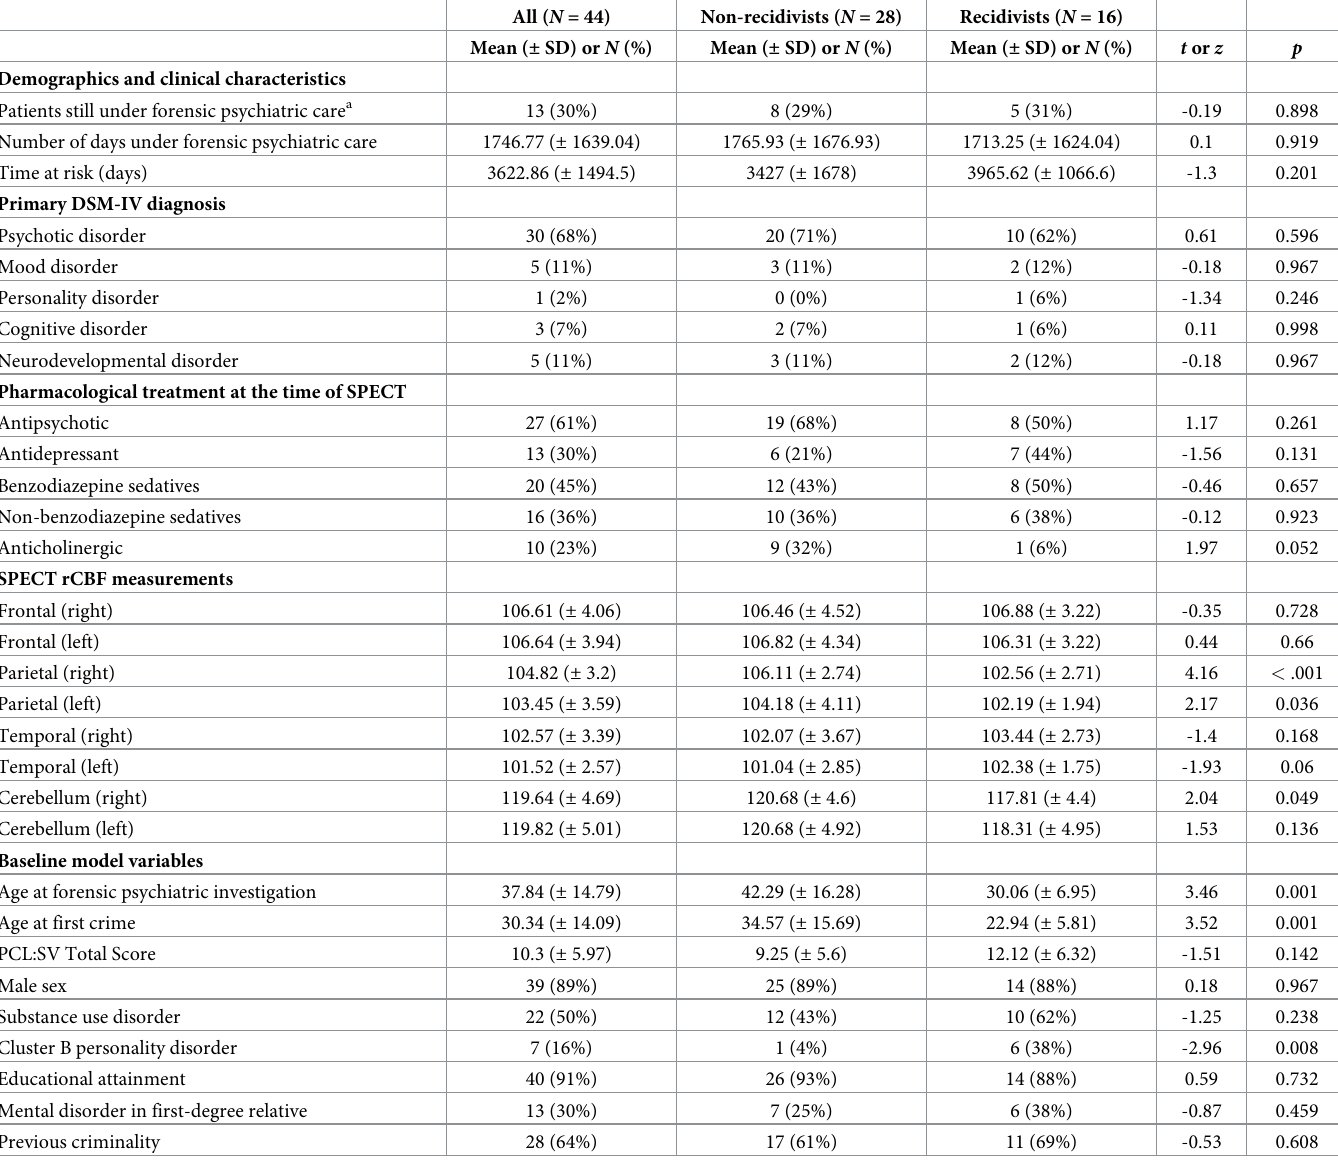
Table 1. Detailed overview of sample clinical